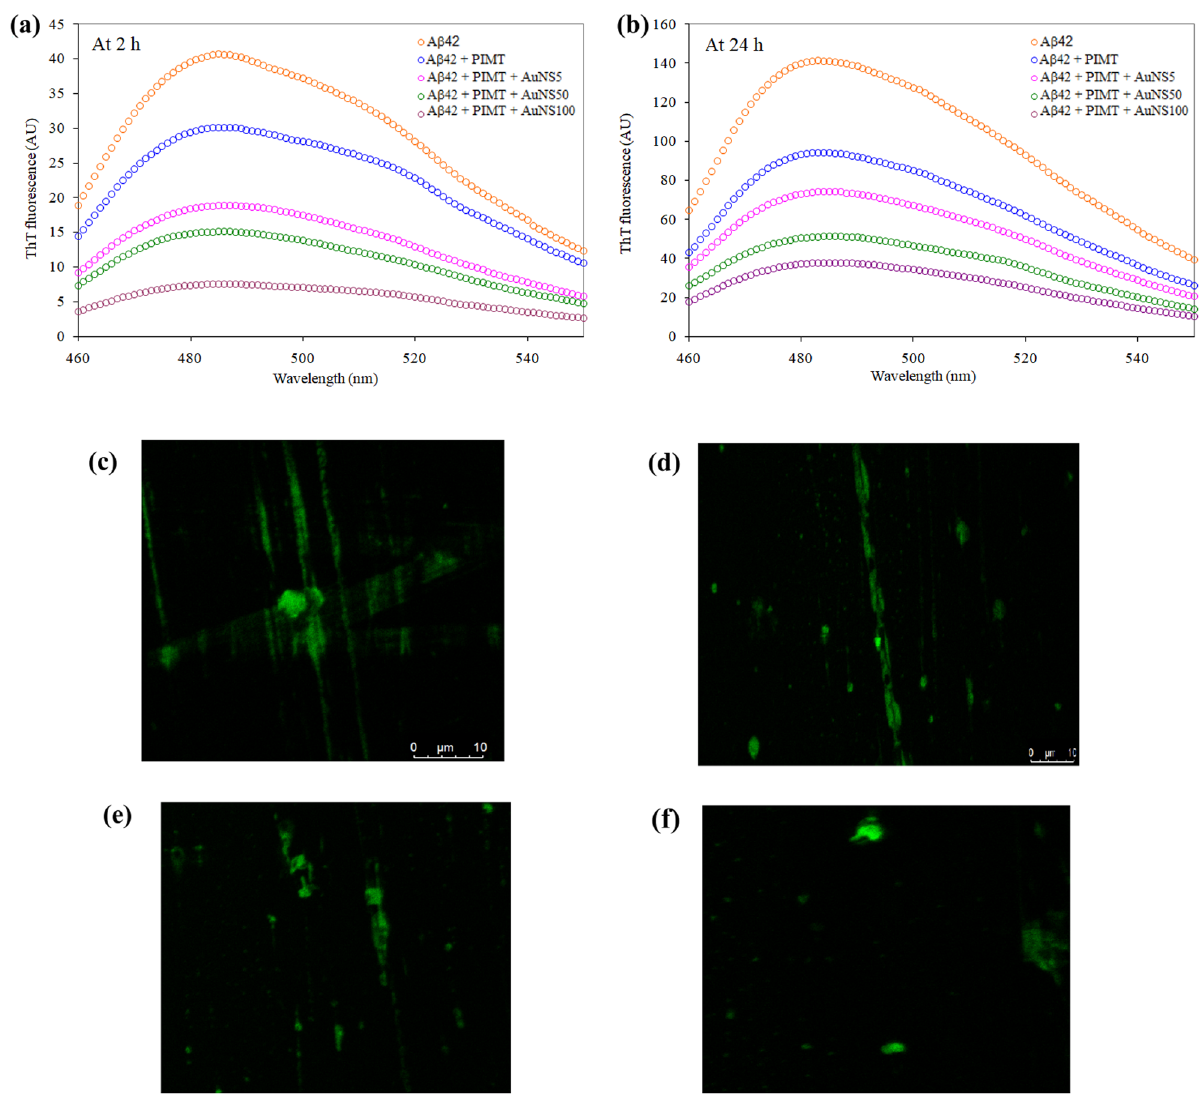
Figure 4. Thioflavin T fluorescence spectra of Aβ42 alone, and after treatment with PIMT and PIMT in presence of AuNSs after ( a ) 2 h and ( b ) 24 h. Samples were excited at 440 nm in 20 mM sodium phosphate buffer (pH 7.2). ( c )–( f ) Confocal microscopic images of Aβ42 fibrils under different conditions, ( c ) peptide alone, and in presence of ( d ) PIMT, ( e ) AuNS100 and ( f ) PIMT and AuNS100 which ruled out any type of protein–ligand electrostatic interaction. PIMT contains three cysteine residues (Cys42, Cys94 and Cys101) and these residues may bind to AuNS via the formation of a coordinate covalent bond between sulfur and gold, as Au–S bond formation is energetically favorable 27,28 . Among different PIMT sequences Cys42 and Cys101 are not conserved, Cys94 is 21 . Cys94 is buried in the structure (with relative solvent accessibility, 2.5), but the other two are exposed (Cys42, 64.6; Cys101, 79.2). While Cys101 is quite away, Cys42 is close to the putative binding site of AuNS (Fig. 5). However, a positive ΔH (Table 2) may possibly suggest that the Cys residue is not involved in coordinating Au. Antiepileptic drugs have been shown to exert allosteric effect on the activity of PIMT, binding close to the active site 10 . It is also possible that AuNS binds to a region around the active site. In human PIMT a cleft is formed between the N-terminal domain and the C-terminal end of the central sheet domain 21 . The putative isoAsp substrate binding site has been proposed to be formed by the sides of the cleft (in particular conserved residues 57–59 and 212–216). However, to bind diverse isoAsp-containing proteins other nearby regions in PIMT are also likely to be used, and in many proteins, such as Vibrio cholera PIMT (which has activity similar to mammalian PIMTs) residues 39–58 are disordered in the apo state 7 . The putative substrate binding site is thus at the bottom of the displayed molecule (Fig. 5). It is likely that AuNSs binding contributes to the ordering near the substrate binding region, thereby increasing the activity. The N- and C-termini regions, which in general are very flexible, are close by and are also likely to get more ordered. It has been shown that when a protein binds to its cognate partner (another protein or DNA), there may be disorder to order transition, or irregular regions taking up secondary structures, and the most observed increase in secondary structure is the extension of already existing